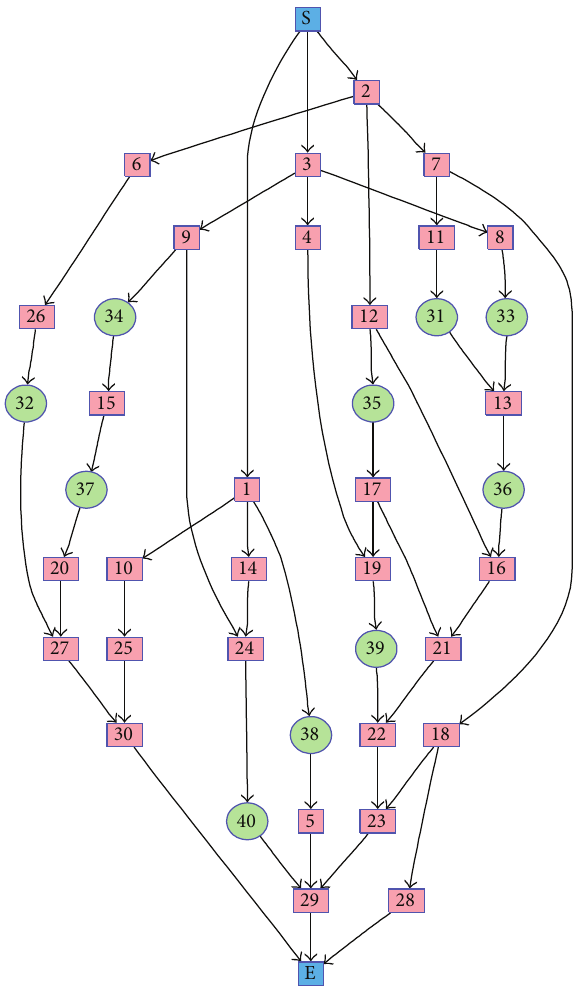
Figure 4: New task precedence labeled TNIS 𝑇 4